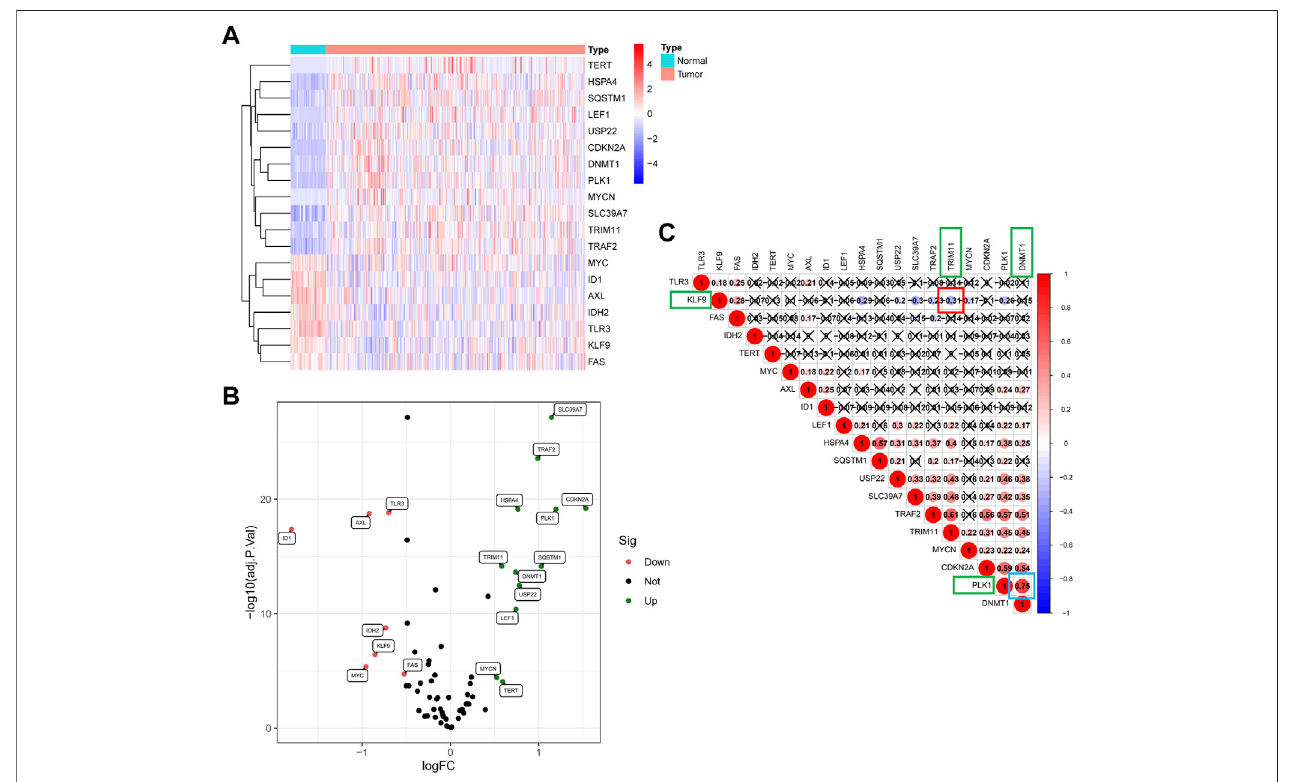
FIGURE2| The landscape ofNRGs intheTCGAcohort. (A) Heatmap ofthedifferentially expressed mRNAsintumor tissues and adjacentnormal tissues. (B) The volcano plot of 19 differentially expressed genes. (C) Correlation analysis of 19 NRGS revealed that DNMT1 has the strongest positive correlation with PLK1 (r = 0.75), and TRIM11 has the strongest negative correlation with KLF9 (r = −